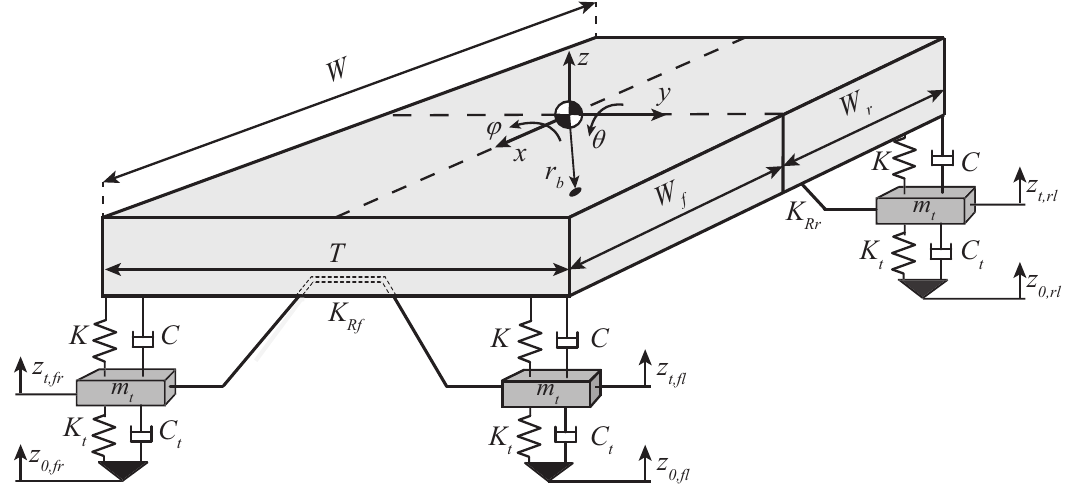
Figure 3. Seven-degree-of-freedom